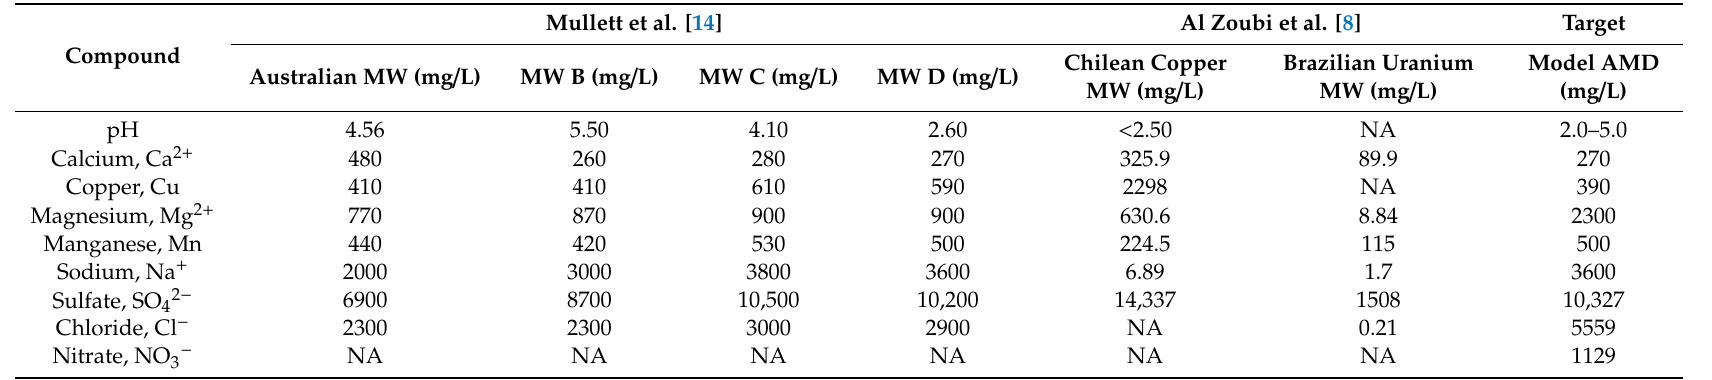
Table 3. Composition of mine water (MW) samples from other works and target composition for model acid mine drainage